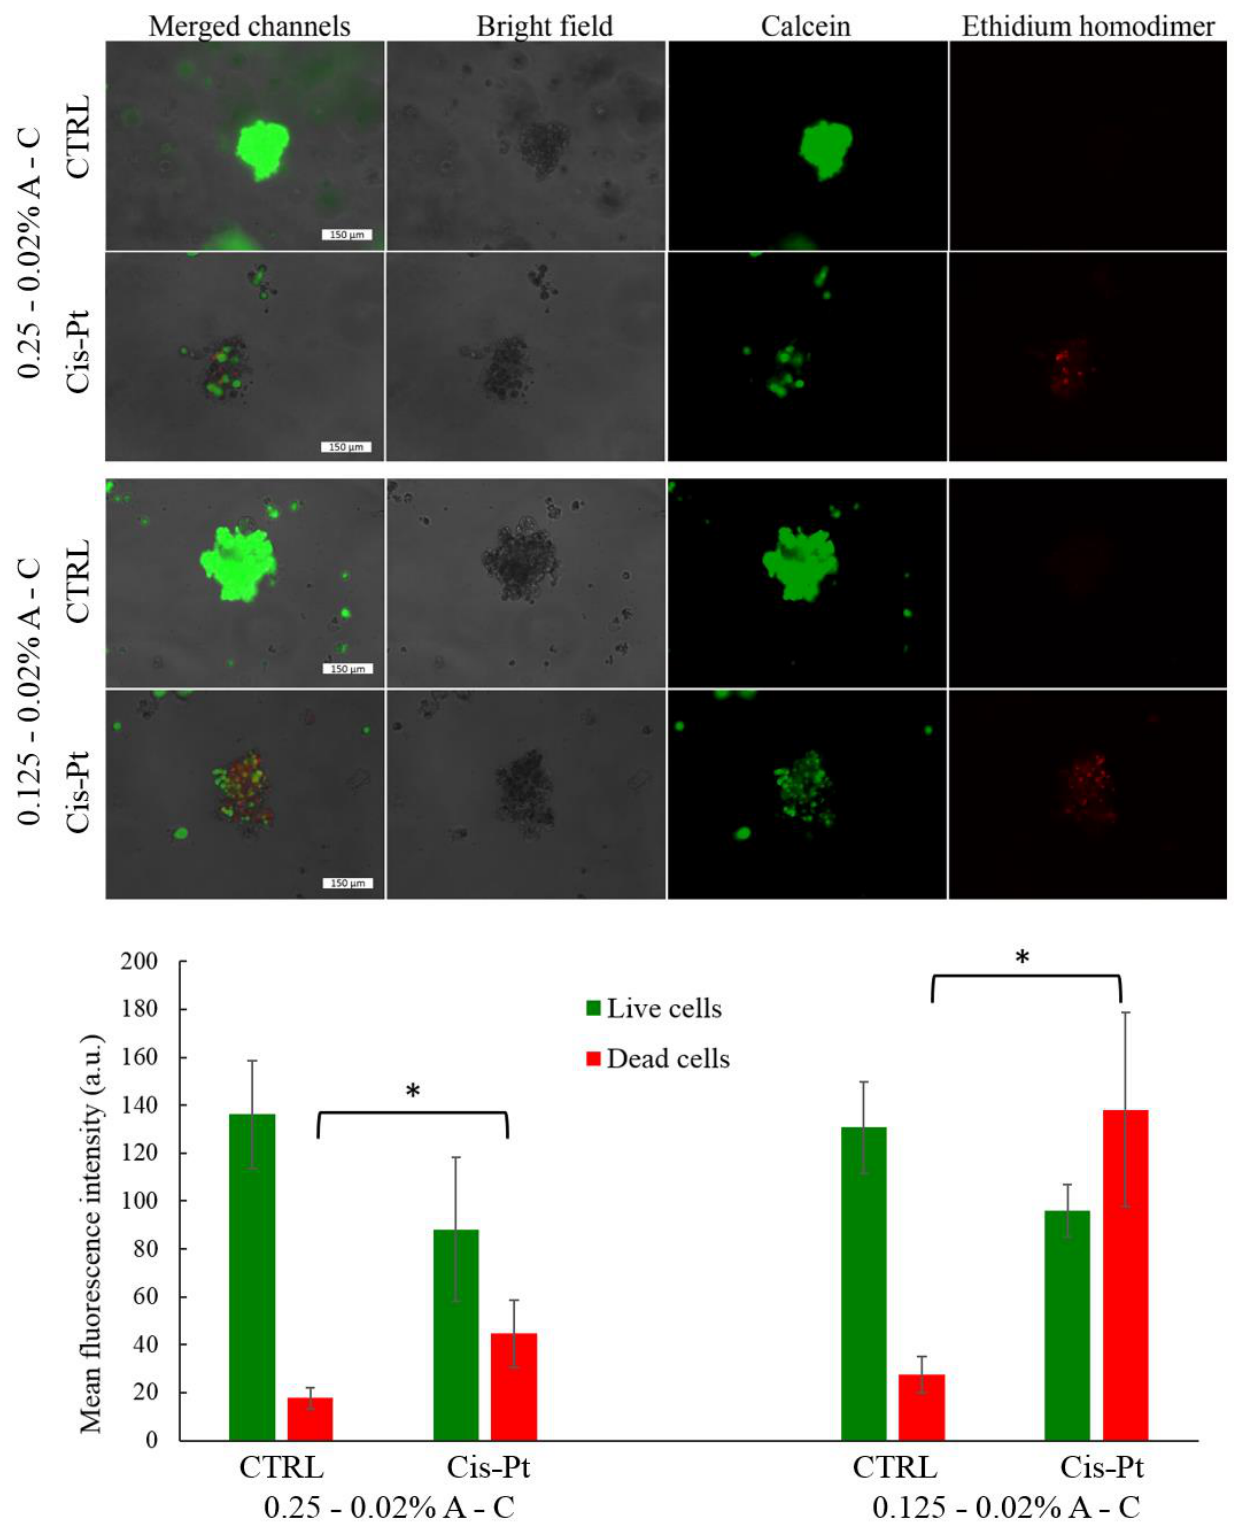
Figure 8. Live/dead assay performed with the MCF-7 spheroids embedded into the 0.25–0.02% ( a ) and 0.125–0.02% A-C hydrogels ( b ) after 24 h incubation with 100 µM cisplatin. ( c ) Mean fluorescent intensity detected in the 0.25–0.02% (left) and 0.125–0.02% (right) A-C hydrogels. Green bars correspond to the fluorescence signal of calcein, while red bars to ethidium homodimer, respectively. (* indicates p < 0.01 when comparing CTRL spheroids with cisplatin-treated spheroids in both types of hydrogel. Statistical significance was assessed by t